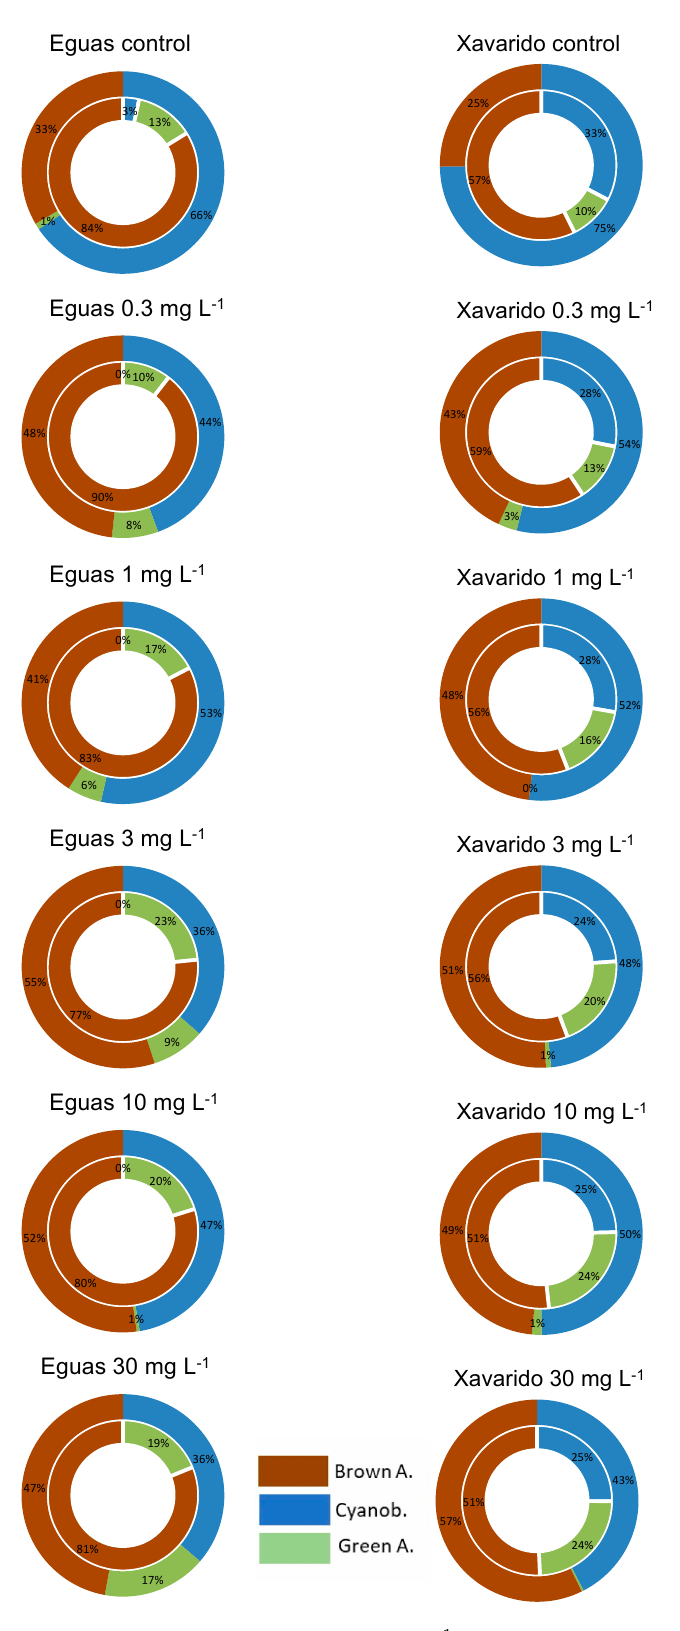
Figure 2. Algae distribution in 0 mg As L − 1 (control) and 30 mg As L − 1 systems from Eguas and Xavarido. Internal circle corresponds to day 0 and external circle to day 42 of the experiment. Brown A.: Brown algae; Cyanob.: Cyanobacteria; Green A.: Green algae.